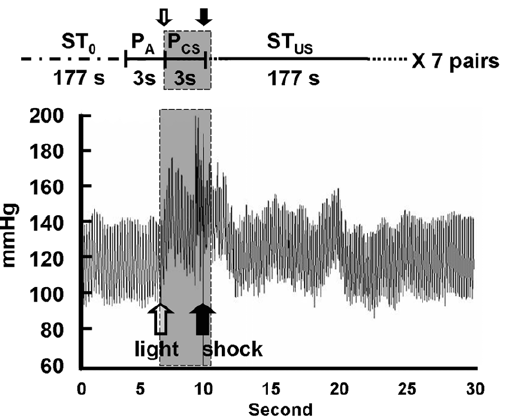
Figure 2. A schematic diagram showing BP alterations induced by light (CS) and footshock (US) during the training session of fear-potentiated startle. The light-on period is marked as the shaded region. P A : averaged BP in 3 s before light on; P CS : averaged BP in 3 s after light on; ST 0 : averaged resting sympathetic tone in 177 s before the initial P A ; ST US : averaged post-US sympathetic tone in 177 s starting at 3 s after a footshock.